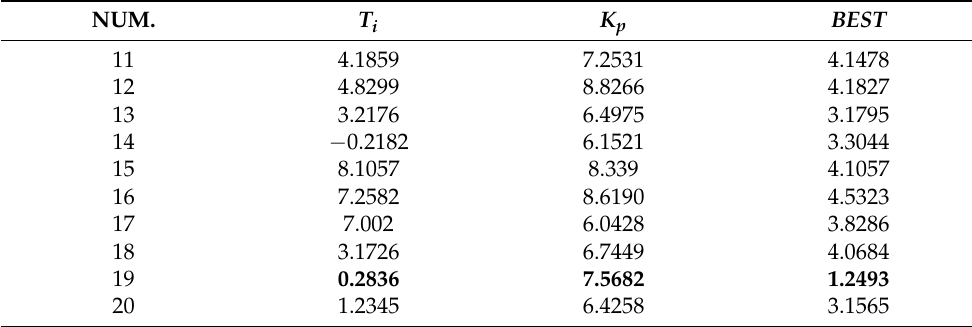
Figure 7. Behavior using PI with optimization values, test 1.